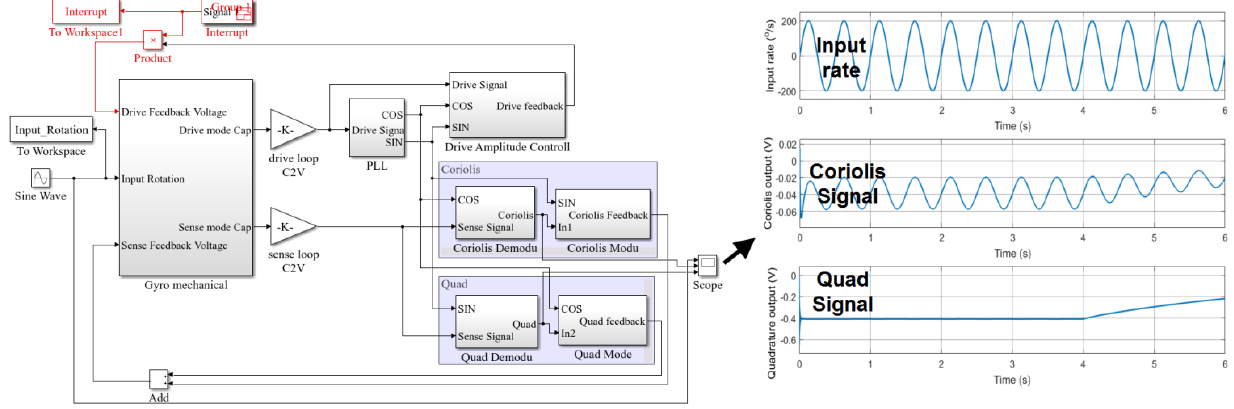
Figure 7. Simulink model for simulating the scenario A malfunction.